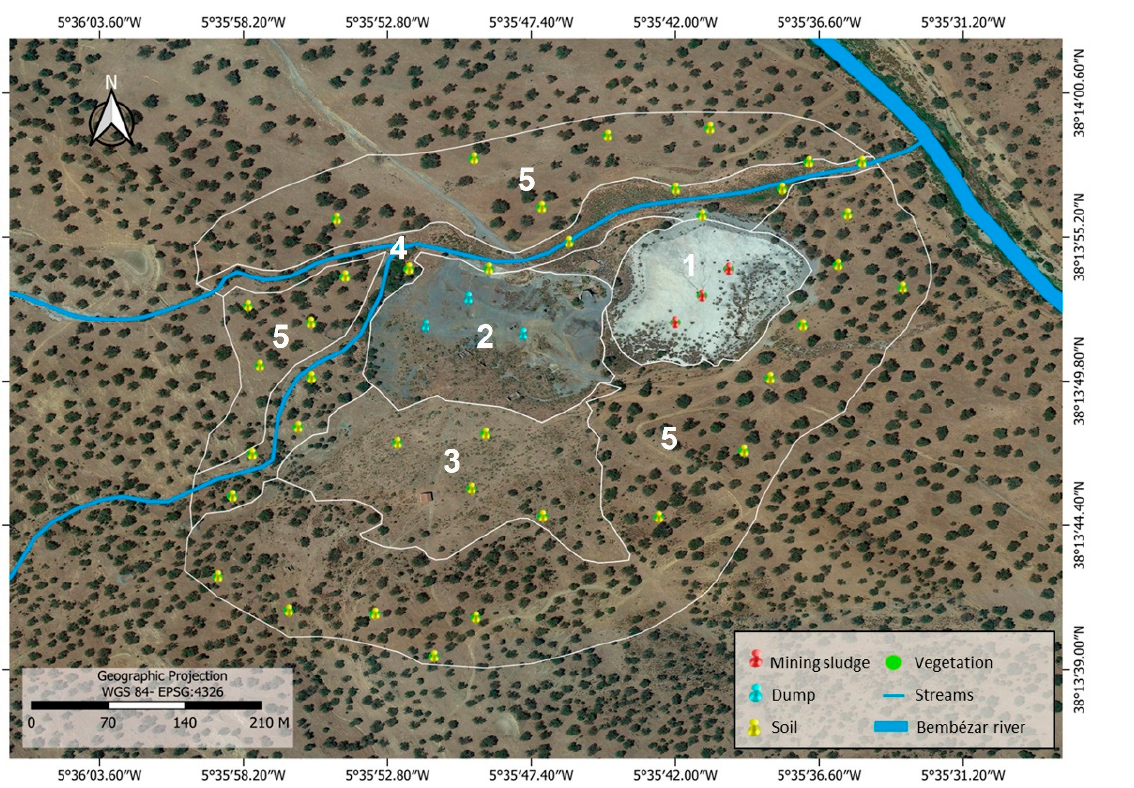
Figure 2. General map of the study area and sampling points: (1) mining sludge, (2) dump, (3) shrubland, (4) riparian zone and (5) dehesa.